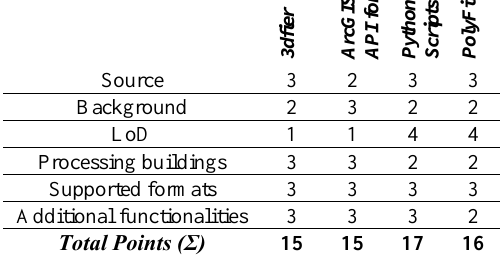
Table 6. Number of points awarded to each